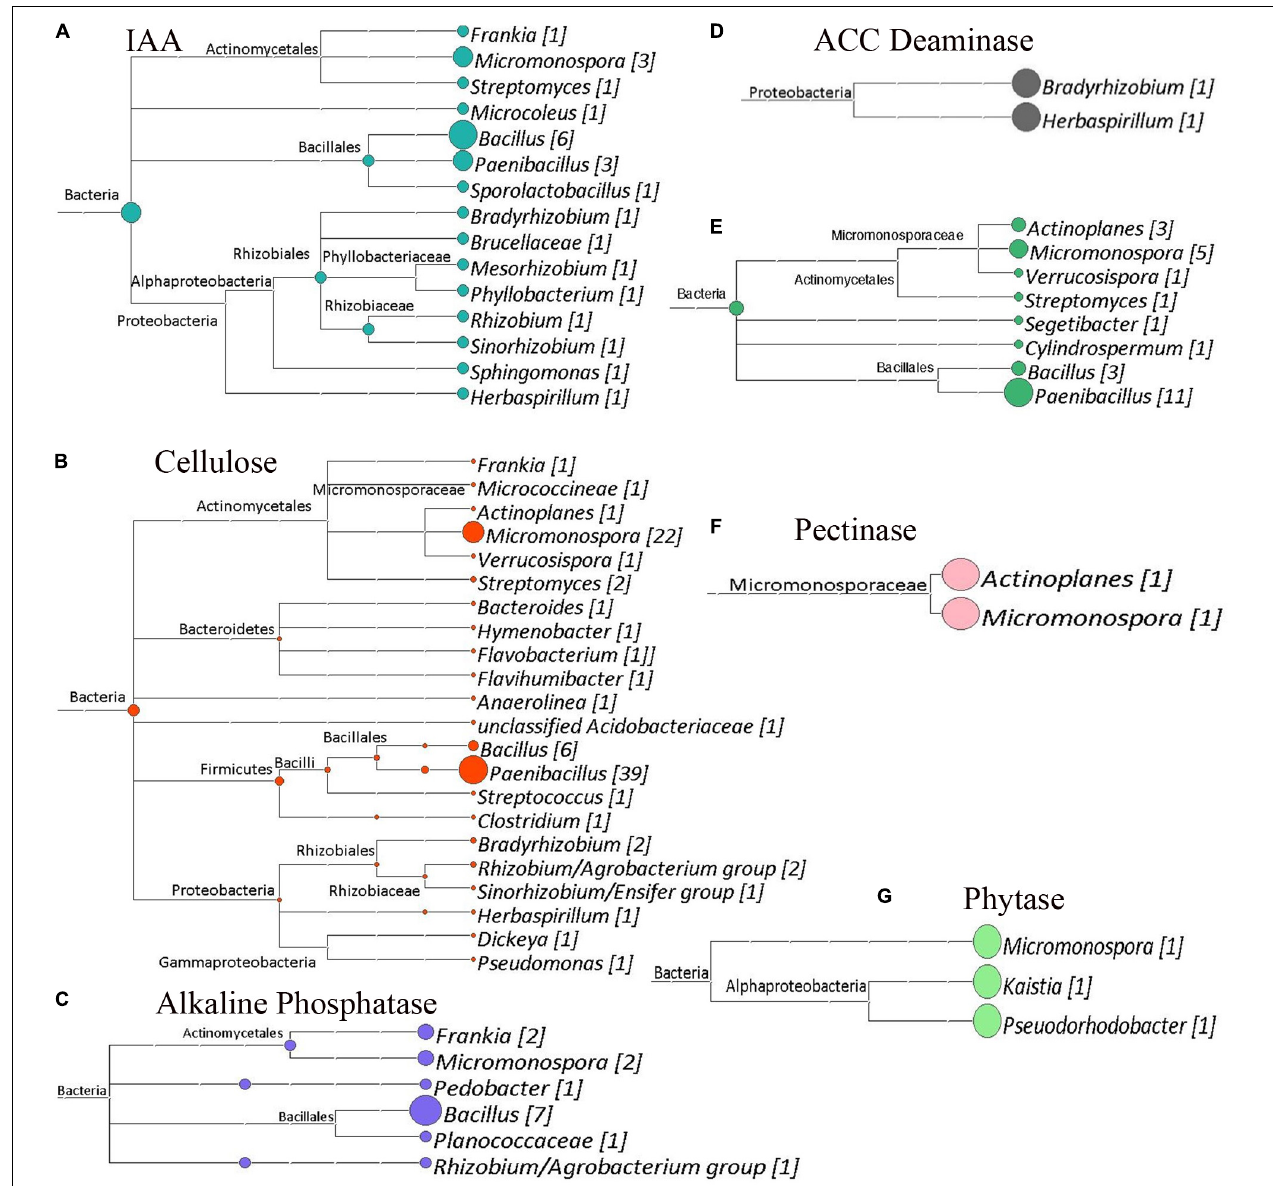
FIGURE 7 | Cladograms of functional genes from Site 1 (Tamra), that were produced by the LCA Algorithm in MEGAN (Version 5). The sizes of colored circles represent that relative contribution of a taxa to the functional genes analyzed in a given cladogram. Numbers in Brackets represent the number of genes that were annotated to a given taxon for that set of genes. (A) Potential indole acetic acid biosynthetic genes. Total genes, 24. (B) Cellulose degrading genes. Total genes identified, 89. (C) Alkaline phosphatase genes. Total genes identified, 26. (D) ACC deaminase genes. Total genes Identified, 2. (E) Chitin degrading genes. Total genes identified, 14. (F) Pectinase genes. Total genes identified, 2. (G) Phytase genes. Total genes identified,